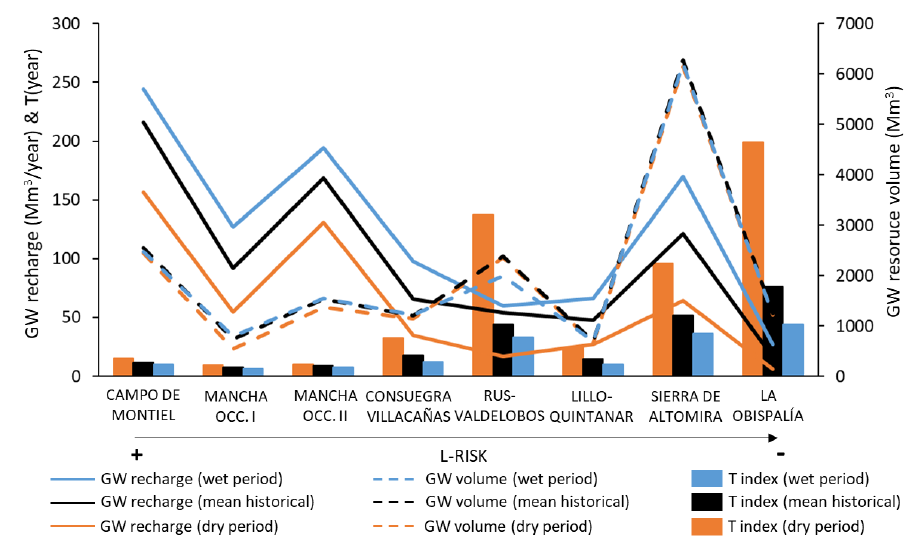
Figure 6. Groundwater recharge (Mm 3 /year), volume of resource (Mm 3 ), and lumped turnover time index (T index) for each aquifer in the Upper Guadiana Basin in the historical period (mean, wet, and dry historical periods).